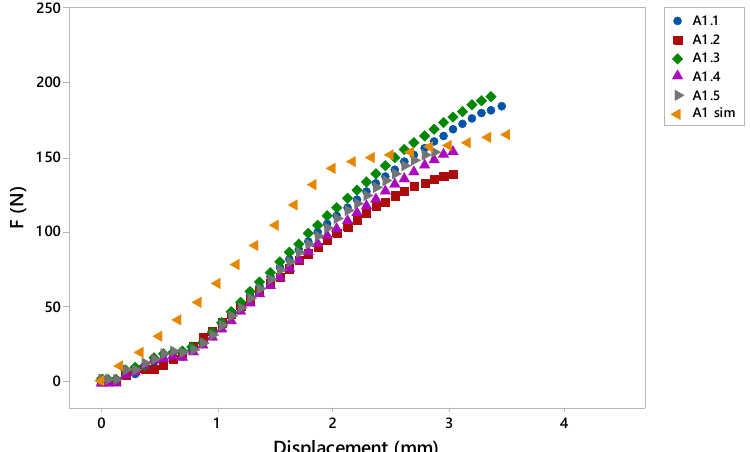
Figure 15. Example comparing the results obtained in the simulation test and the experimental studies.